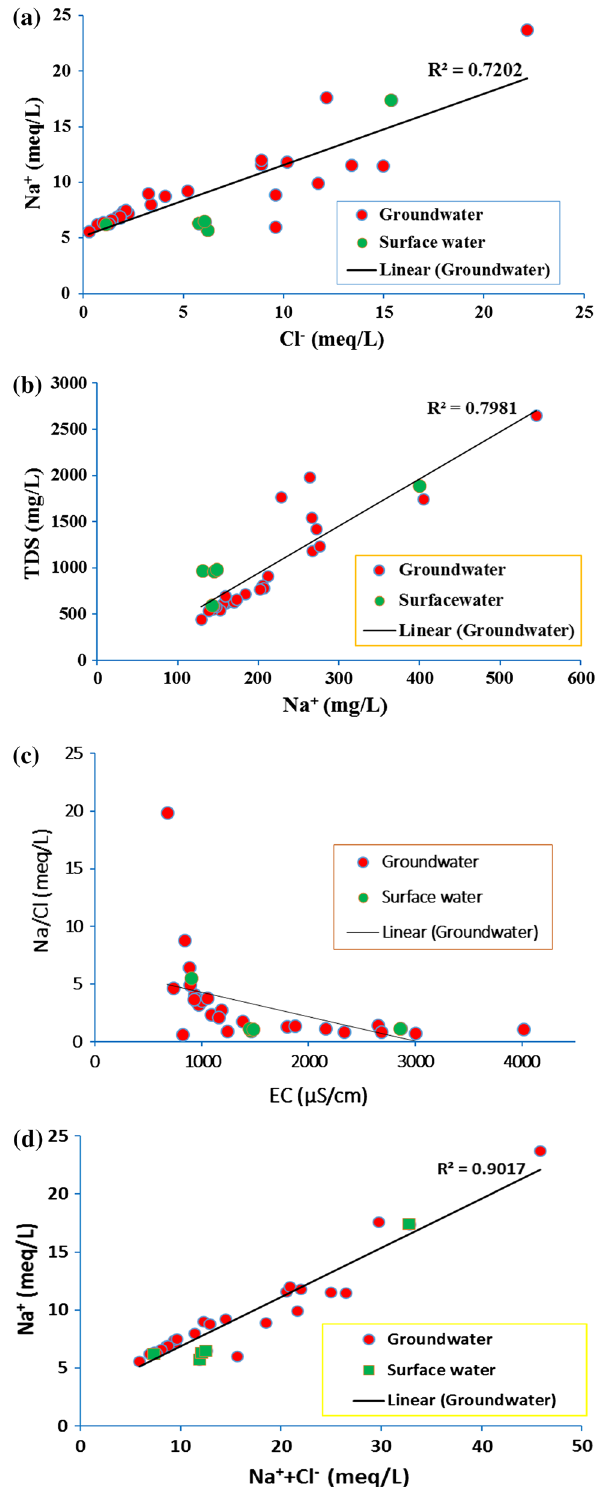
Fig. 15 Relation between a Na + and Cl − , b Na + and TDS, c Na + /Cl − and EC, d Na + and (Na + + Cl −